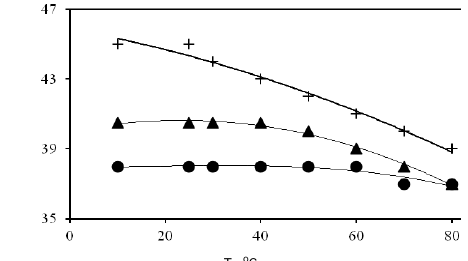
Figure 4. The variation of surface pressure π surfactants Polysorbate-80 (+), Polysorbate-40 ( ) and Polysorbate-20 (